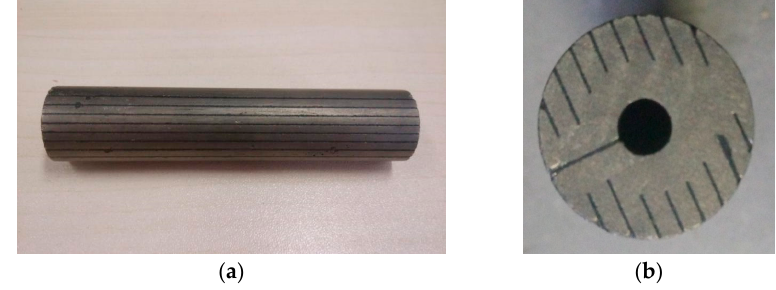
Figure 2. Terfenol-D rod after section treatment. ( a ) Terfenol-D rod; and, ( b ) Section treatment.